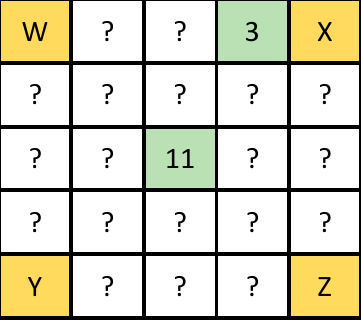
Figure 2. The explanation of kriging analysis employed in ArcGIS for spatial interpolation of geotechnical information.